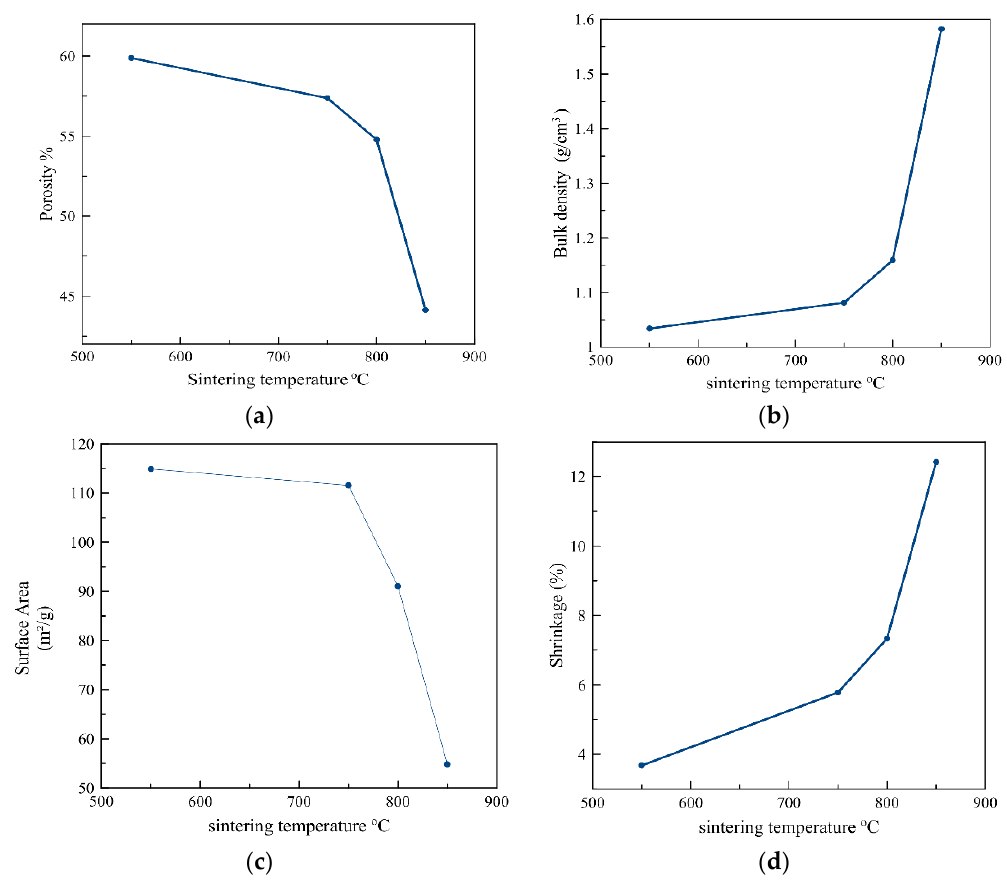
Figure 3. Simulated effect of the sintering temperature on: ( a ) Porosity, ( b ) Bulk density, ( c ) Surface area, and ( d ) Shrinkage.